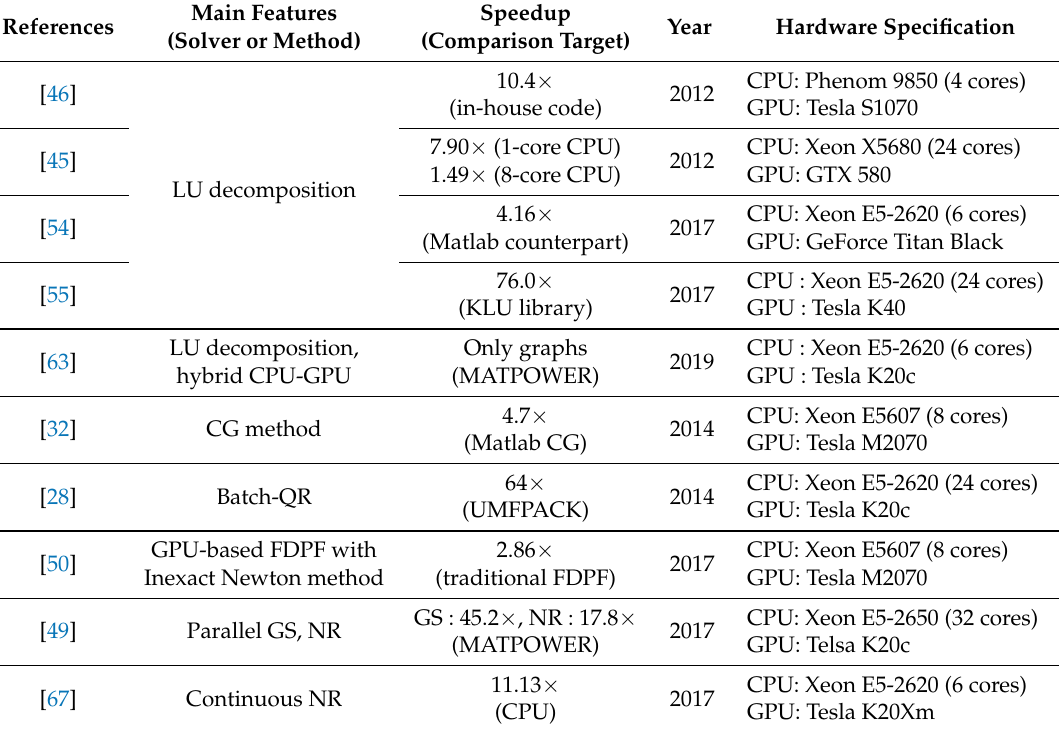
Table 3. Comparison of main features and